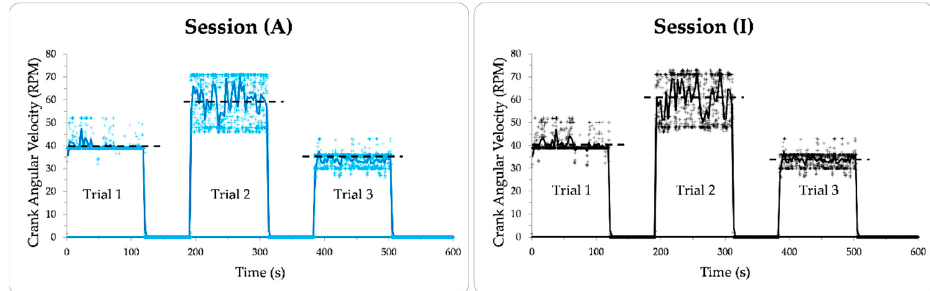
Figure 6. The distribution of real-time crank angular velocity (marker style “+”) and its average (solid line, window = 3 s) during sessions (A) and (I) through Trials 1 to 3. The target angular velocity is shown with the dashed line.